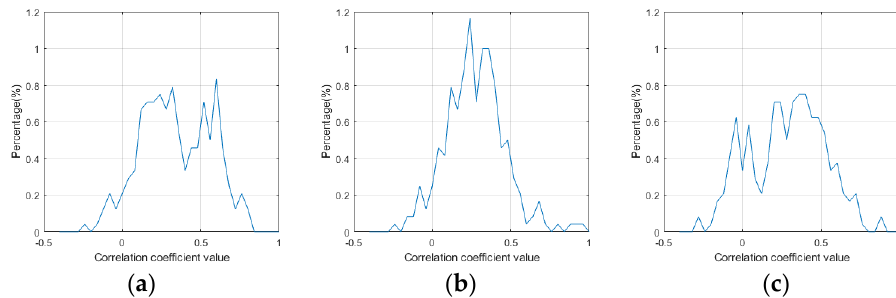
Figure 10. Histograms of the correlation coefficient of the block in three image sets. ( a ) Target images, ( b ) fake images using DCGAN, and ( c ) fake images using GA.